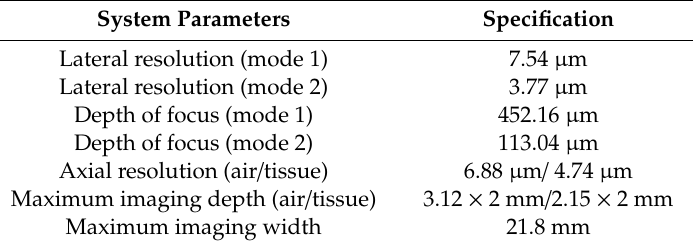
Figure1. Experimentalsetupfordual-channelspectraldomainopticalcoherencetomography(SD-OCT). BS: unpolarized beam splitter; M: mirror; the diagram within the green dashed box is a schematic of two imaging modes, in which f is the focal length of the focusing lens. Table 1. The parameters of the dual-channel SD-OCT